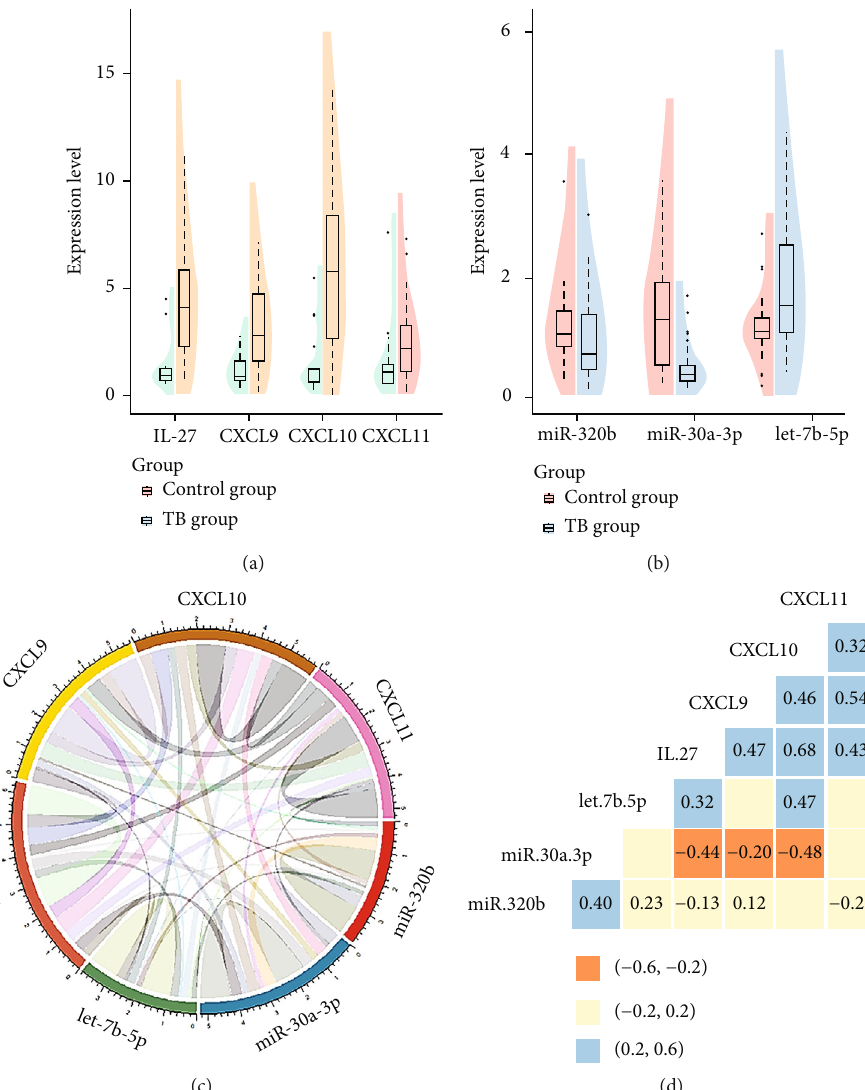
Figure 6: qRT-PCR results. (a) Expression of interleukin-27 and CXCL9/10/11. (b) Expression of miR-320b, mir-30a-3p, and let-7b-5p. (c, d) Correlation